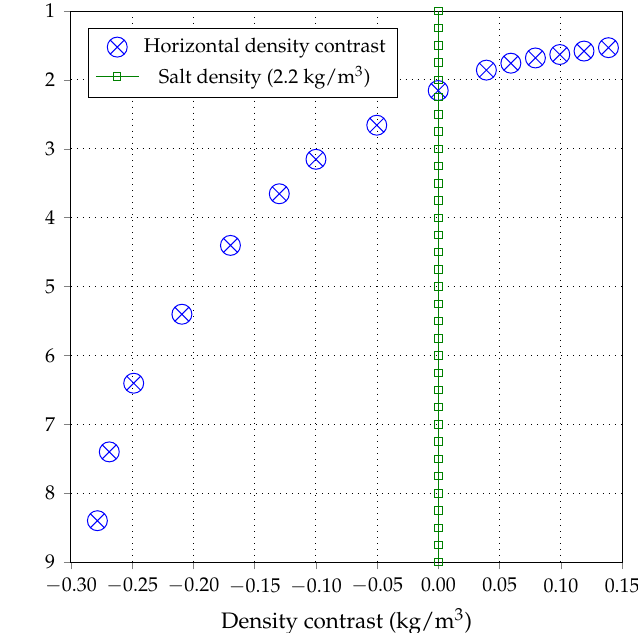
Figure 6. Compaction curve relative to sediments in Gulf of Mexico [36].